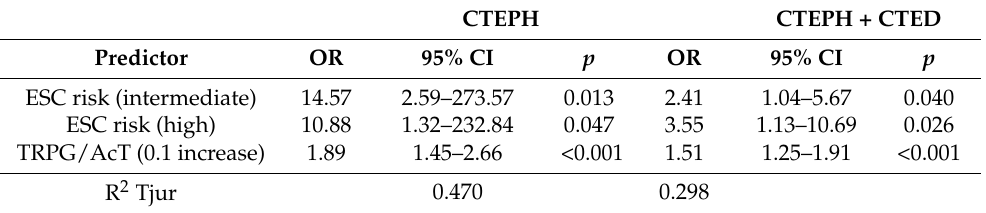
Table 5. Regression models predicting CTEPH and pooled CTEPH and CTED based on the echocar- diographic probability of pulmonary hypertension stratification and TRPG/AcT